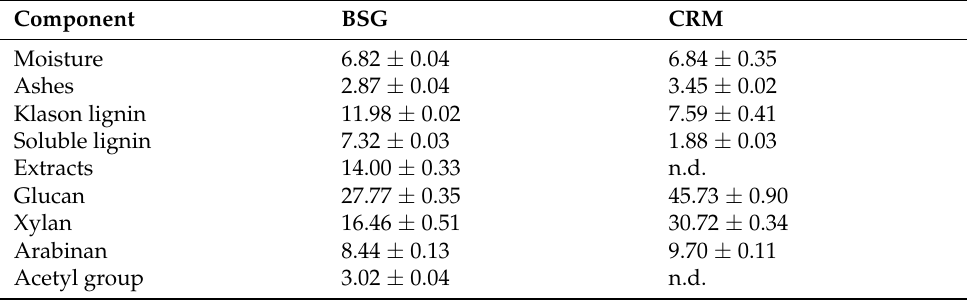
Table 1. Composition of BSG and CRM expressed as g per 100 g of dry solid.